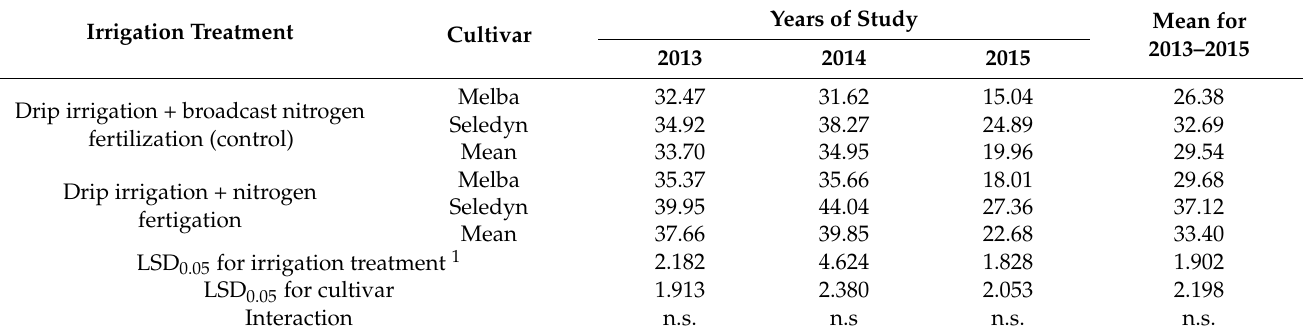
Table 3. Influence of drip fertigation on the total marketable yield of fruits (t ha − 1 ) of Melba and Seledyn melon cultivars in the years